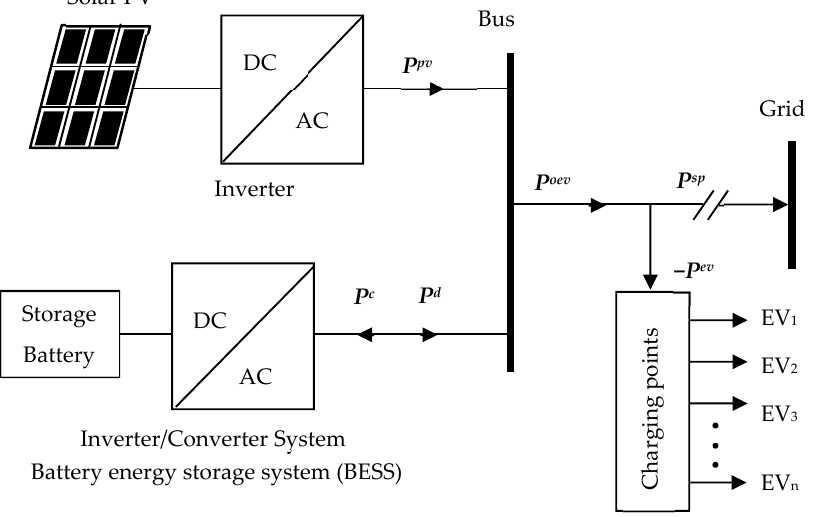
Figure 1. Solar PV-based EV charging system with the grid.